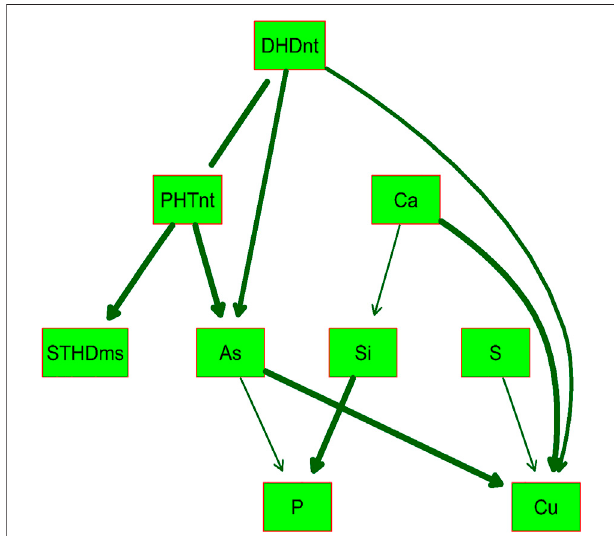
FIGURE 2 | Directed acyclic graph (DAG) of the validated Bayesian network for nine arsenic-related traits determined in the USDA-ARS Rice Minicore (RMC) population with signi fi cance level of p = 0.001. The thickness of arrows between traits in green boxes represents the strength of the relationship.Straightheaddiseaseseveritywasdeterminedover2 yearsusing MSMA-treated soil (StHDms) in Stuttgart, AR. Days to heading (DHDnt) and plantheight(PHTnt) weredetermined inthesame2 yearsandlocationusinga native soil area (not treated with MSMA). Hull silica concentration (Si) was determined using rice grown in 1 year, two locations (Beaumont, TX and Stuttgart,AR),andtworeplicationseach.Grainconcentrationsofarsenic(As), phosphorus (P), sulfur (S), calcium (Ca), and copper (Cu) were determined in grains produced using 2 replications × 2 years at Beaumont,